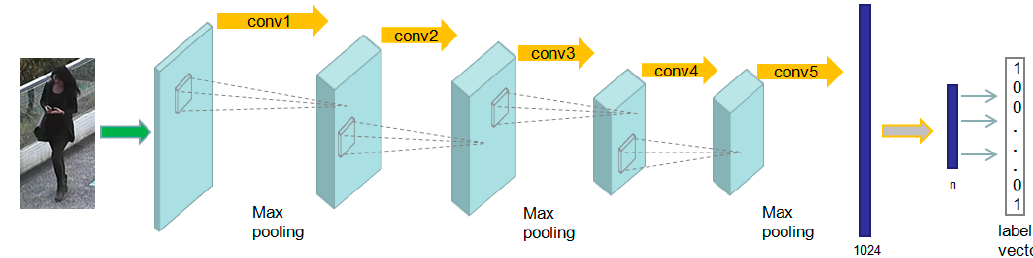
Figure 1. The framework of lightweight CNN used for pedestrian attributes recognition.